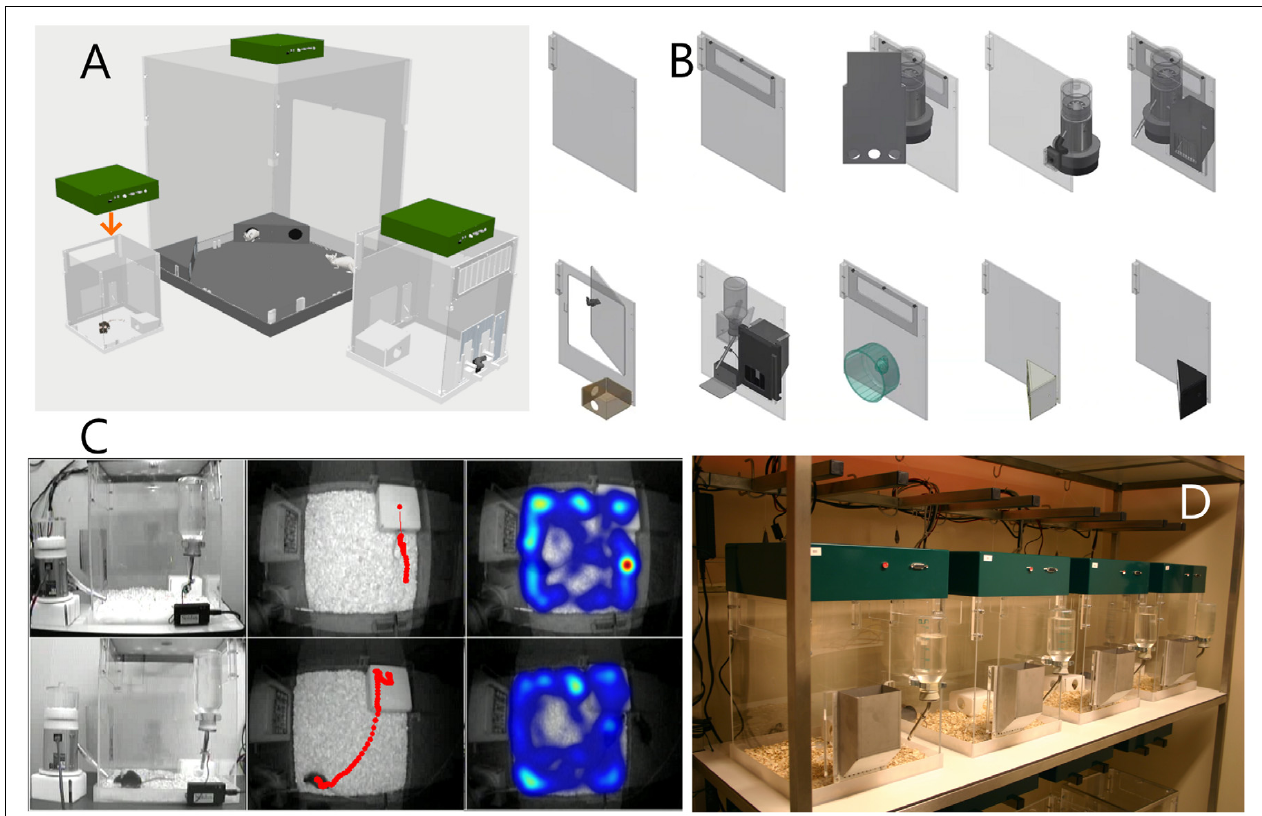
FIGURE 1 | The four pillars of Noldus PhenoTyper as a home cage monitoring system. (A) Different cage sizes can be combined with the same device (the Top Unit) that functions as the interface between the cage and the video-tracking system. Left, 30 × 30 cm cage for single mouse; middle, 90 × 90 cm for rat social interaction; might, 45 × 45 cm for single rat or mouse social interaction. (B) Cages can be made of different functional components, easily assembled, disassembled and cleaned. (C) Control of stimuli and recording of behavior and analysis is performed by the EthoVision XT software. Left: external view of two cages during a conditioning experiment where the mouse must sit on top of the shelter in order to receive a reward. Cages are provided with a pellet dispenser for the rewards and a lickometer to additionally measure drinking behavior. Middle: view from the Top Unit with tracks. In the cage at the top, the dot on the shelter indicates that the mouse is inside the shelter; the time spent in the shelter is also measured. In the other cage, the mouse has just received a reward after it was detected on the top of the shelter. Right: example of locomotor/exploration behavior visualized as heatmaps. (D) Cages can be placed in standard racks and tests are performed simultaneously, with up to 16 cages per EthoVision XT workstation. The subjects are usually released and taken by lifting the feeding